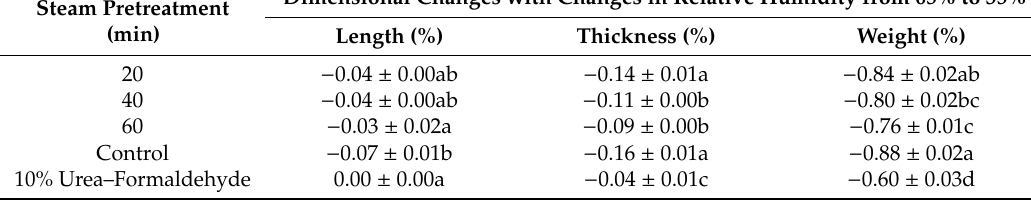
Table 3. Dimensional changes with changes in relative humidity from 65% to 35% of particleboards made without synthetic adhesive with steam-pretreated particles.